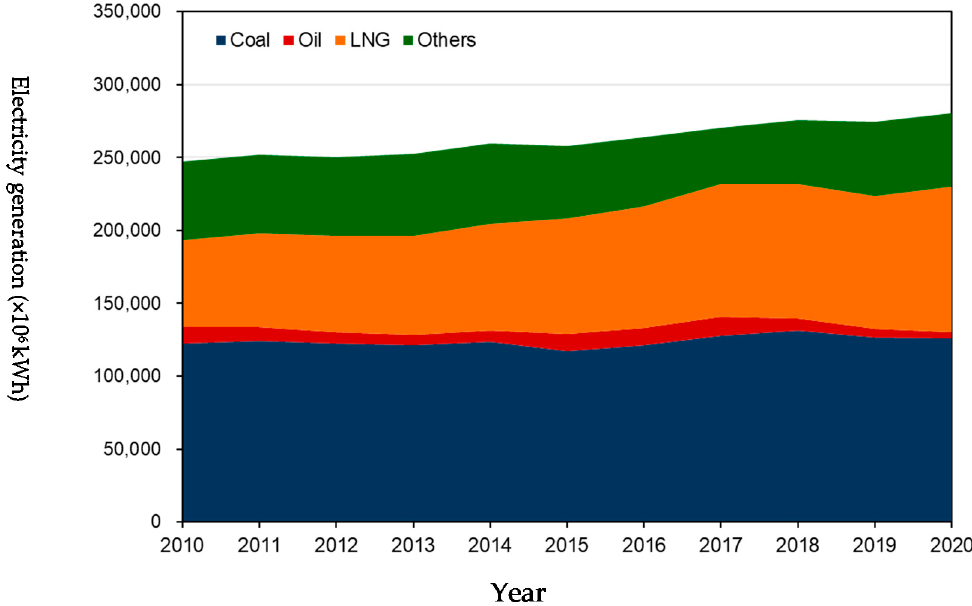
Figure 1. Profiles of power generation in Taiwan